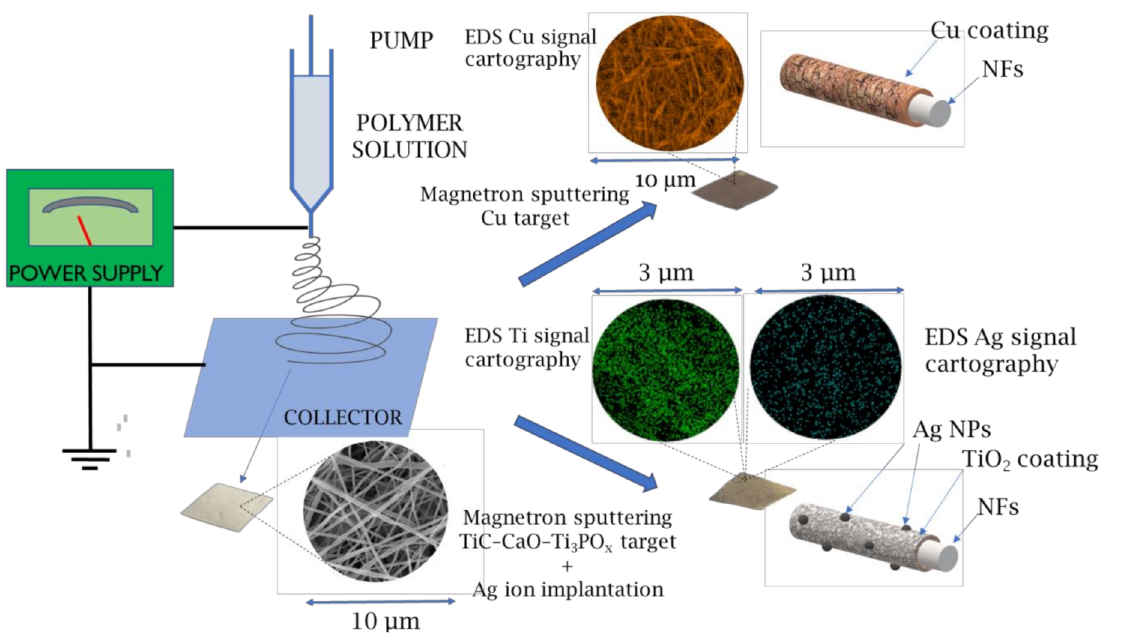
Figure 1. Scheme of the multistep process for antibacterial and antiviral nanofibers (NFs) preparation based on the electrospinning of polymers, magnetron sputtering of Cu or TiC-CaO-Ti 3 PO x targets and implantation of silver. SEM-EDX mapping (in colored circles) is shown for the qualitative representation of synthesized